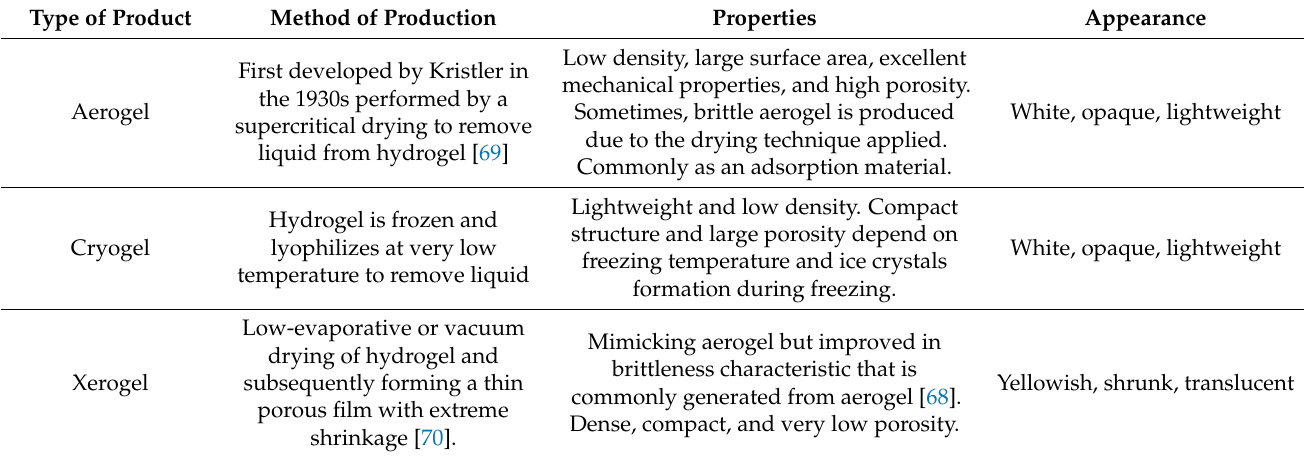
Figure 4. Single and double hydrogel network modified by PAAm. Table 3. Extended products from hydrogel fabrication.